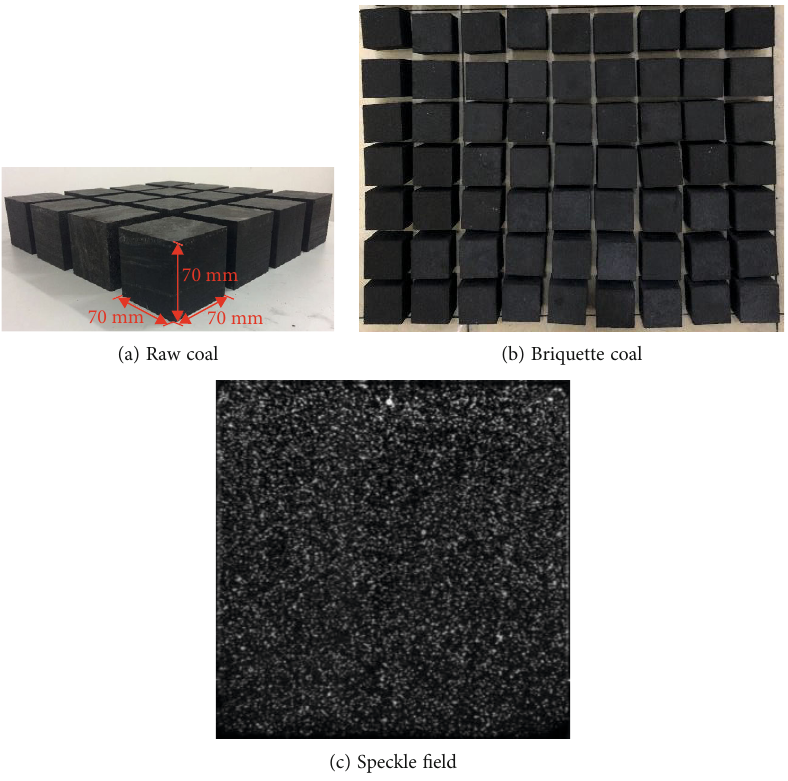
Figure 2: Coal samples in